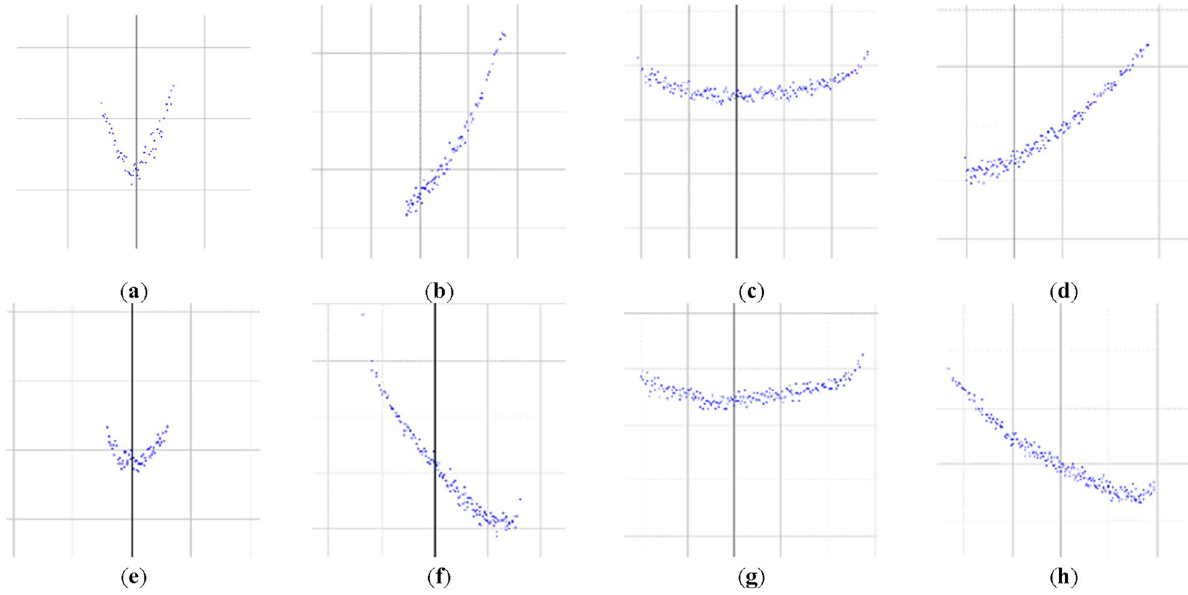
Figure 3. The scan results by LIDAR with different angle. ( a ) 0°, ( b ) 30°, ( c ) 90°, ( d ) 120°, ( e ) 180°, ( f ) 240°, ( g ) 270° scan result, ( h )